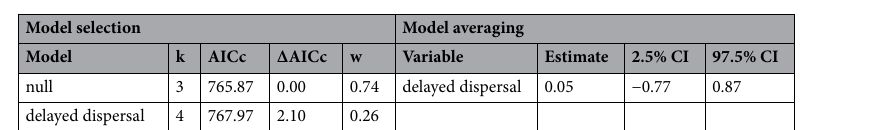
Figure 3. ( a ) Annual productivity (mean ± 95% CI) of urban (black dots) and rural (white dots) breeding pairs at nests never occupied or occupied at least one year by a family unit. ( b ) Natal dispersal distances (in meters) of urban burrowing owls Athene cunicularia delaying dispersal (black points: observed values, black dashed line: median; n = 89 m) compared to the frequency distribution of distances expected if they were recruiting into the breeding population after dispersing during their first year of life (non-delayed dispersal).